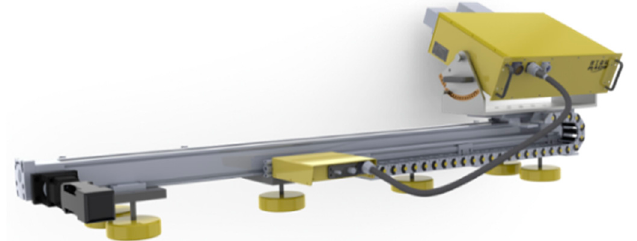
Figure 8. Ground-based synthetic aperture radar (GB-SAR) system.